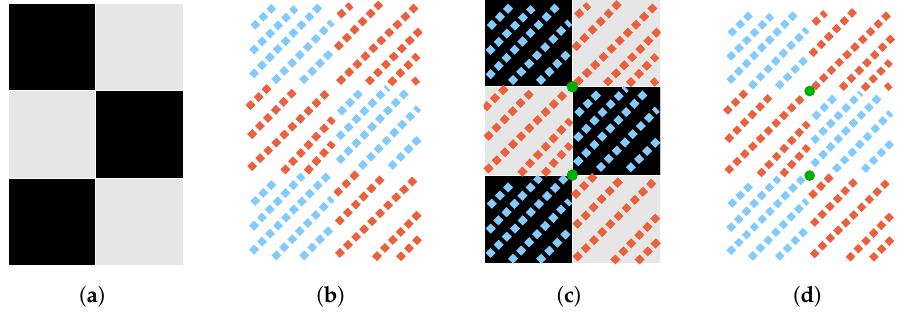
Figure 5. The principle used to estimate corners in the points. ( a ) The chessboard model; ( b ) The scanned point cloud of the chessboard. Colors indicate the intensity (blue for low and red for high reflectance intensity); ( c ) Find a matrix that translates the most 3D points on the corresponding patterns. Green points are estimated corners; ( d ) Consider the corners of the chessboard model as the corners of the point